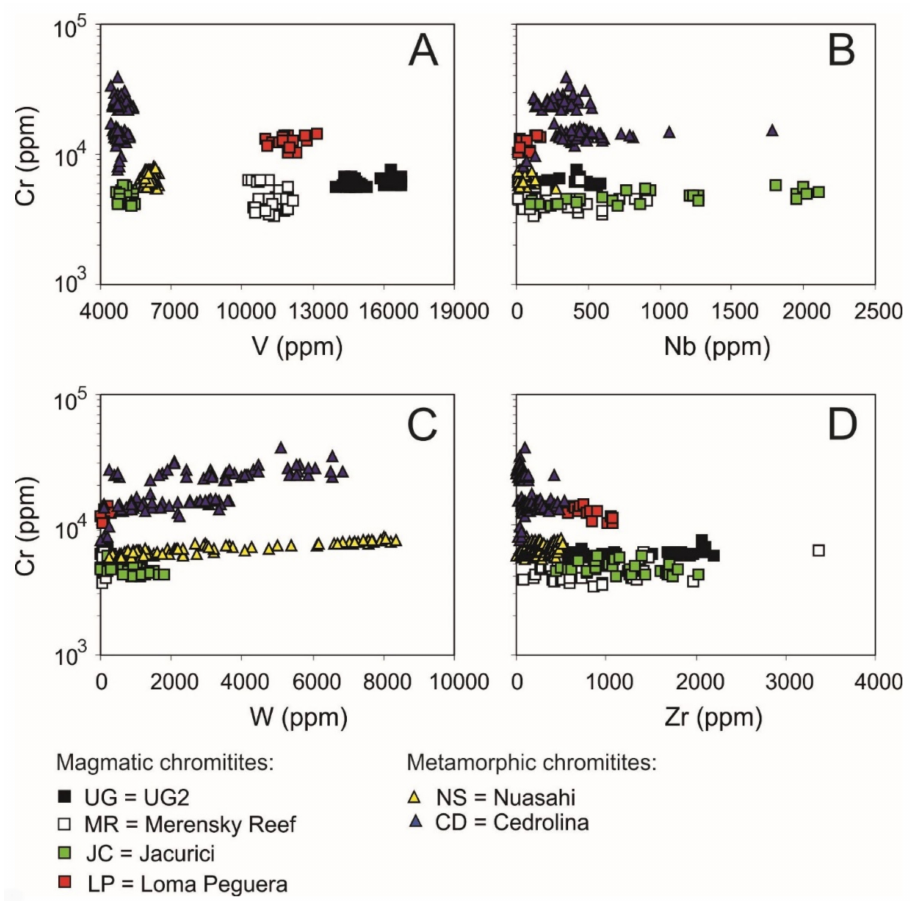
Figure 10. Trace element (V, Nb, W, Zr) variations versus Cr in accessory rutile from chromitite (concentrations in ppm). Cr versus V ( A ); Cr versus Nb ( B ); Cr versus W ( C ); Zr versus Cr ( D ). Wolfram was detected in 76% of rutile analyses, varying from close to detection limit (UG2, MR, LP) to 1808 ppm (JC), and maximum concentrations of 8334 ppm and 6836 ppm in NS and CD, respectively (Table